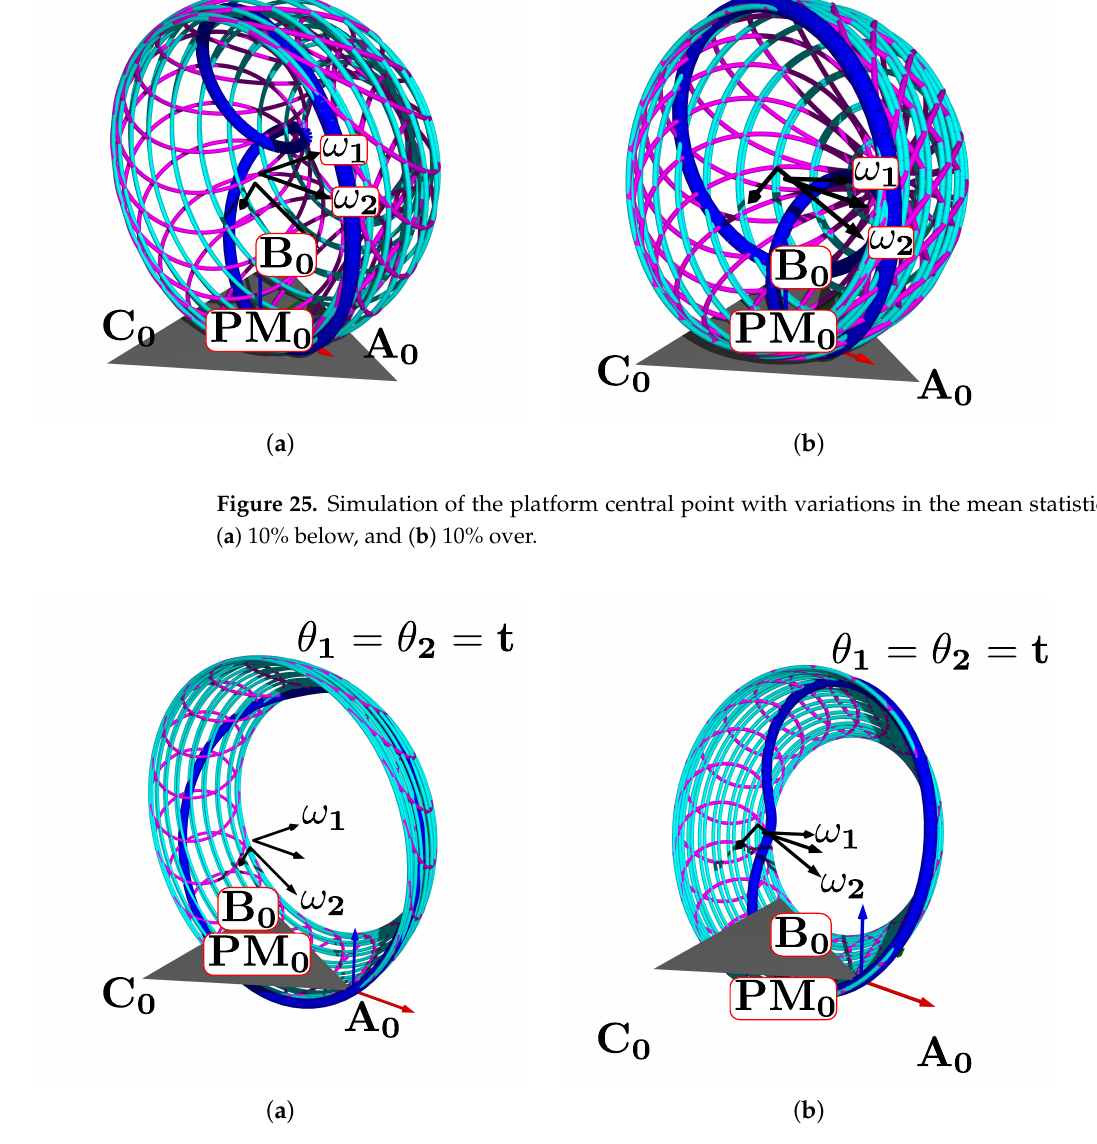
Figure 26. Simulation of the platform’s attaching point A: ( a ) mean values plus 10%, ( b ) mean values minus